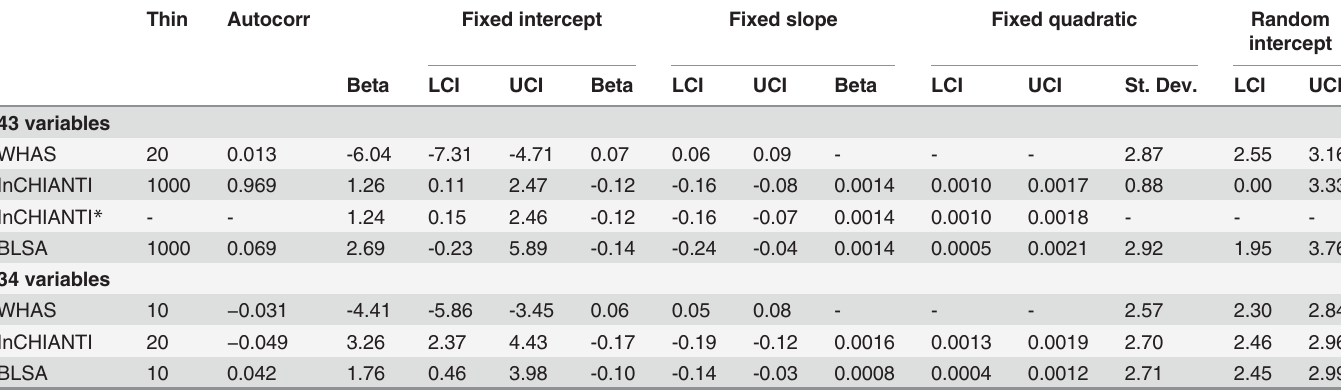
Table 3. Results of Bayesian mixed trajectory models of PCA1 with age, best models.